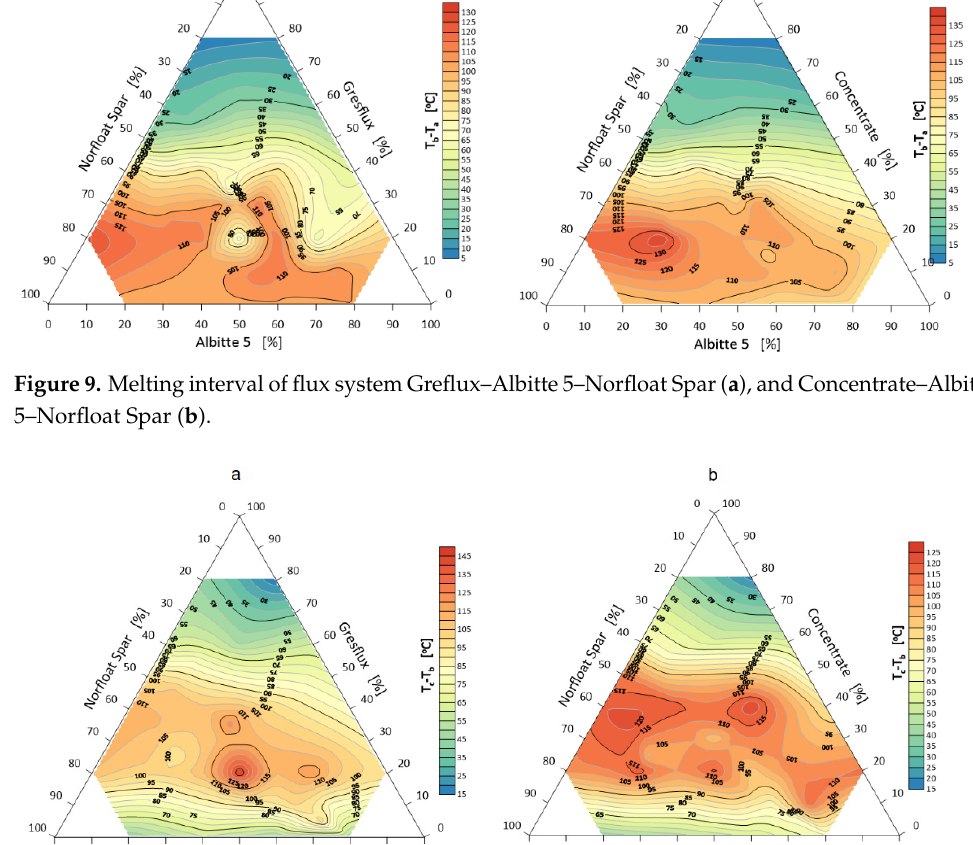
Figure 10. Flowing interval of a flux system Greflux–Albitte 5–Norfloat Spar ( a ), and Concentrate– Albitte 5–Norfloat Spar ( b ).